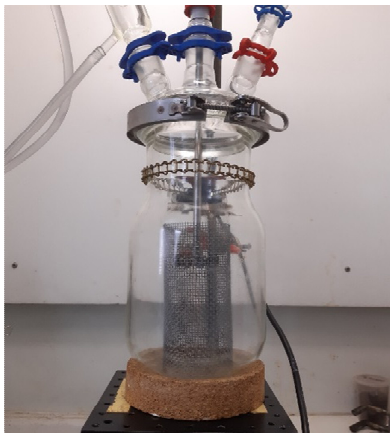
Figure 1. Experimental device used for dissolution experiments using mechanical stirring.